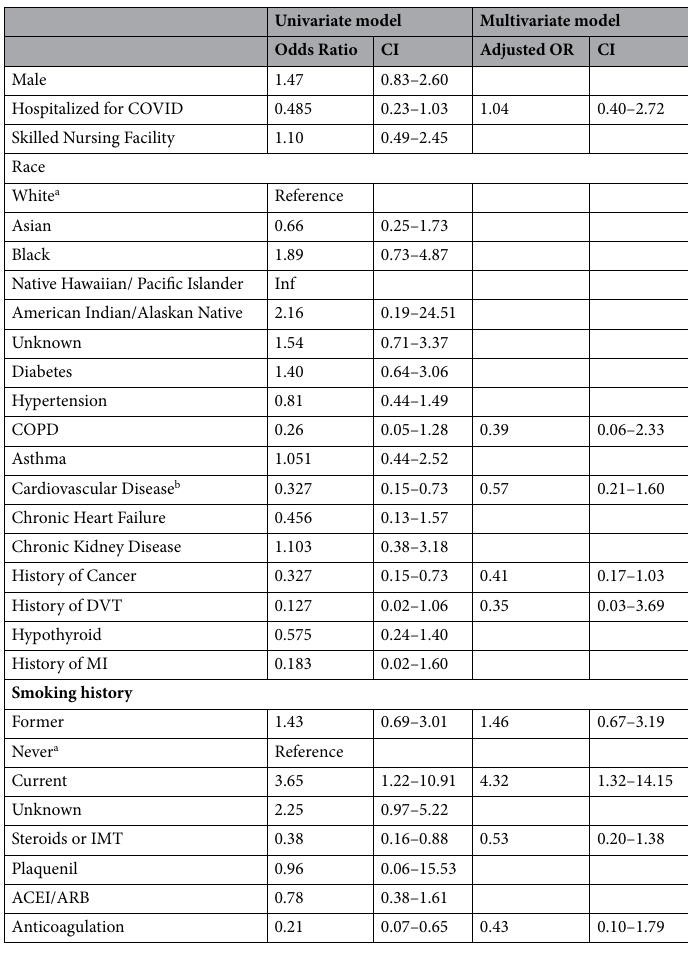
Table 6. Univariate and Multivariate Logistic Regression Results for Clinical Outcomes in Clade 1 group compared to Clade 2 group. a Reference value. b Cardiovascular disease defined as history of MI, CVD/ stroke, CHF, valvular diseases (s/p CABG). All diseases were defined using ICD-9 and ICD-10 codes. DVT Deep Venous Thrombosis; COPD chronic obstructive pulmonary disease; MI myocardial infarction; ACEI angiotensin-converting enzyme inhibitors; ARB angiotensin receptor blocker; IMT immunomodulatory therapy. Only variables that had p values < 0.05 in univariate analysis were entered in Multivariate Regression Results. In multi-categorical variables (Race and Smoking History), Odds ratios were calculated against each reference